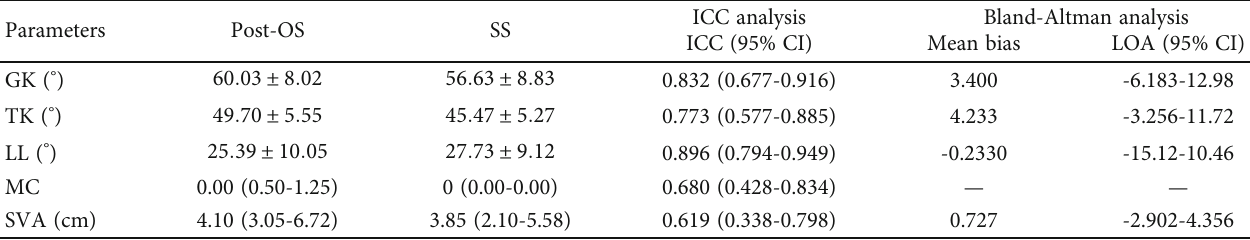
Table 2: Results of ICCs and Bland-Altman analysis for radiological measurement in Post-OS and SS models.